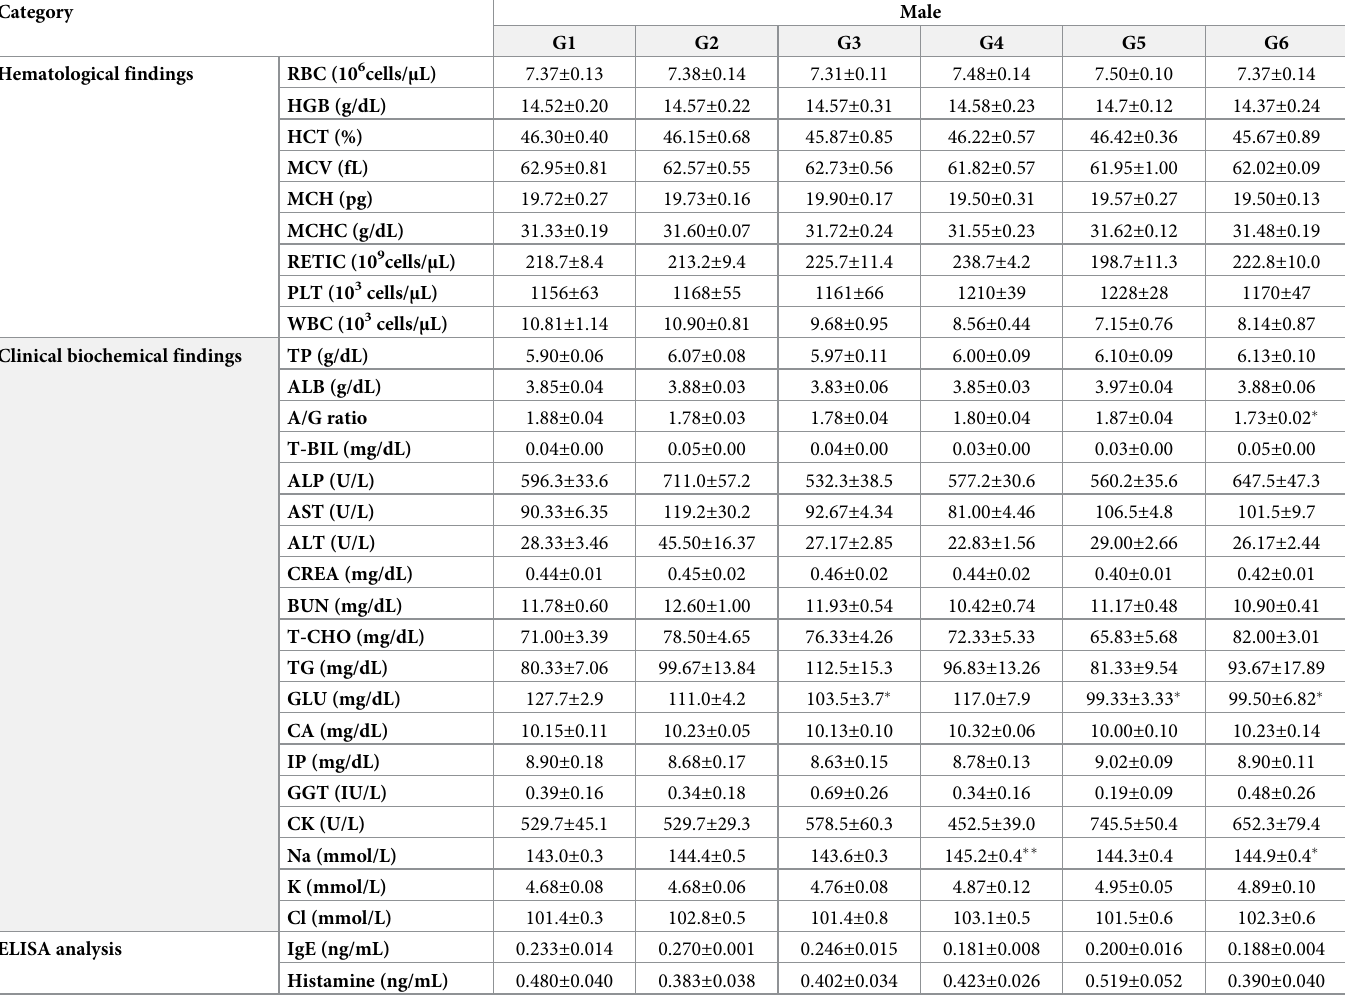
Table 2. Hematology, clinical biochemistry, and serum IgE and histamine levels in male Sprague-Dawley (SD) rats.